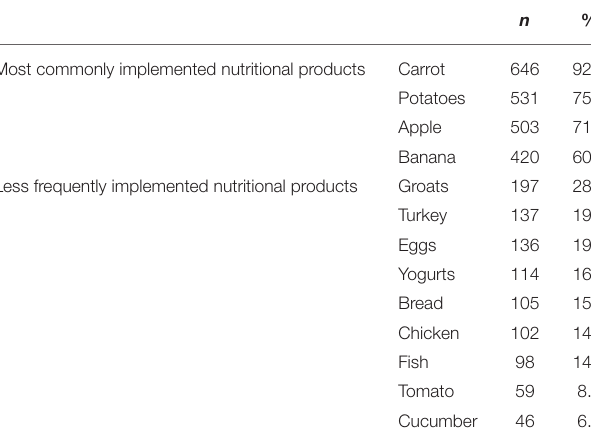
TABLE 6 | Use of the BLW method and children’s independence in making feeding decisions.